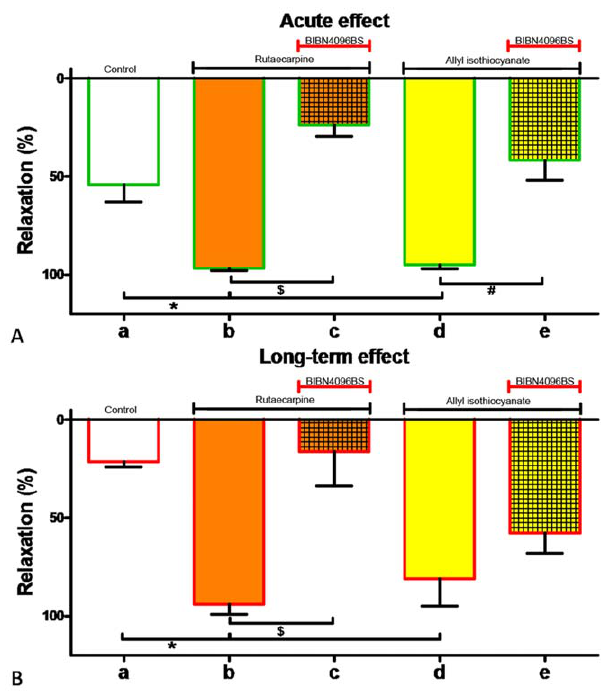
Figure 4. Stimuli of SMN, like rutaecarpine and allyl isothio- cyanate, relax endothelinergic arterial contraction and prevent the persistent contractile effect of ET-1. Isolated rat mesenteric resistance arteries were precontracted with 16 nM ET-1. Increasing concentrations of vasodilator compounds were administered until a maximal effect was observed. Thereafter vasoactive stimuli were removed from the organ chamber while the recording of active wall tension continued for . 10 min. A, maximal acute relaxing effects of rutaecarpine and allyl isothiocyanate. B, long-term effects of rutaecar- pine and allyl isothiocyanate. a, time control; b, rutaecarpine; c, rutaecarpine in presence of BIBN4096BS; d, allyl isothiocyanate; e, allyl isothiocyanate in presence of BIBN4096BS. For concentrations of vasodilators see ‘‘Methods’’ section. n=6–8. *, $ and # : P , 0.05 vs. control, rutaecarpine and allyl isothiocyanate,